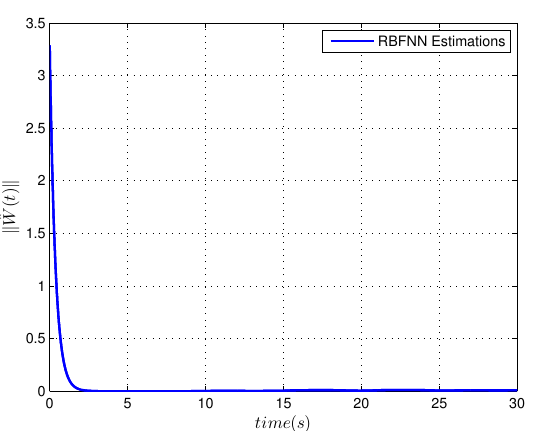
Figure 6. UAV’s Control Inputs.